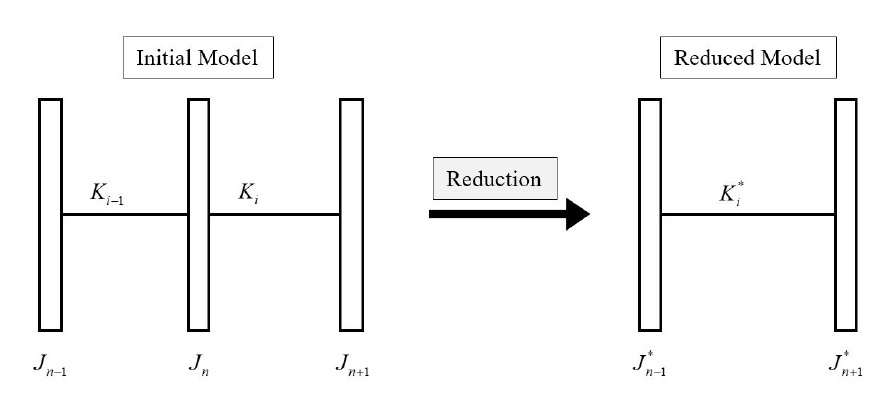
Figure A1. Conceptualization of the model reduction method proposed by Rivin